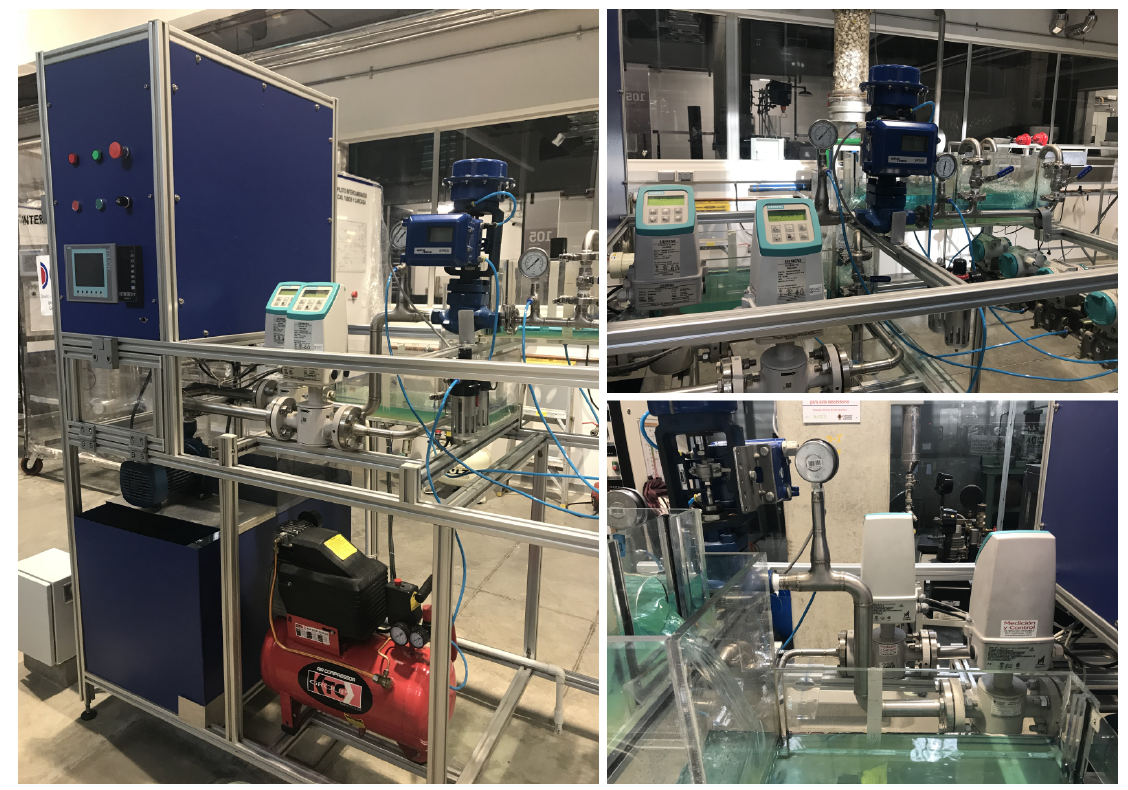
Figure 8. Multipurpose experimental